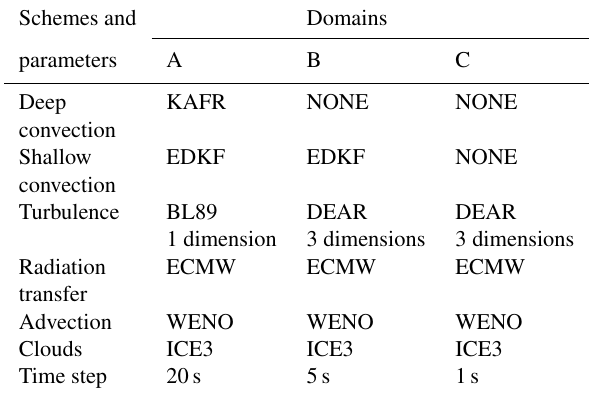
Table 1. Summary of the Meso-NH physical schemes used in the